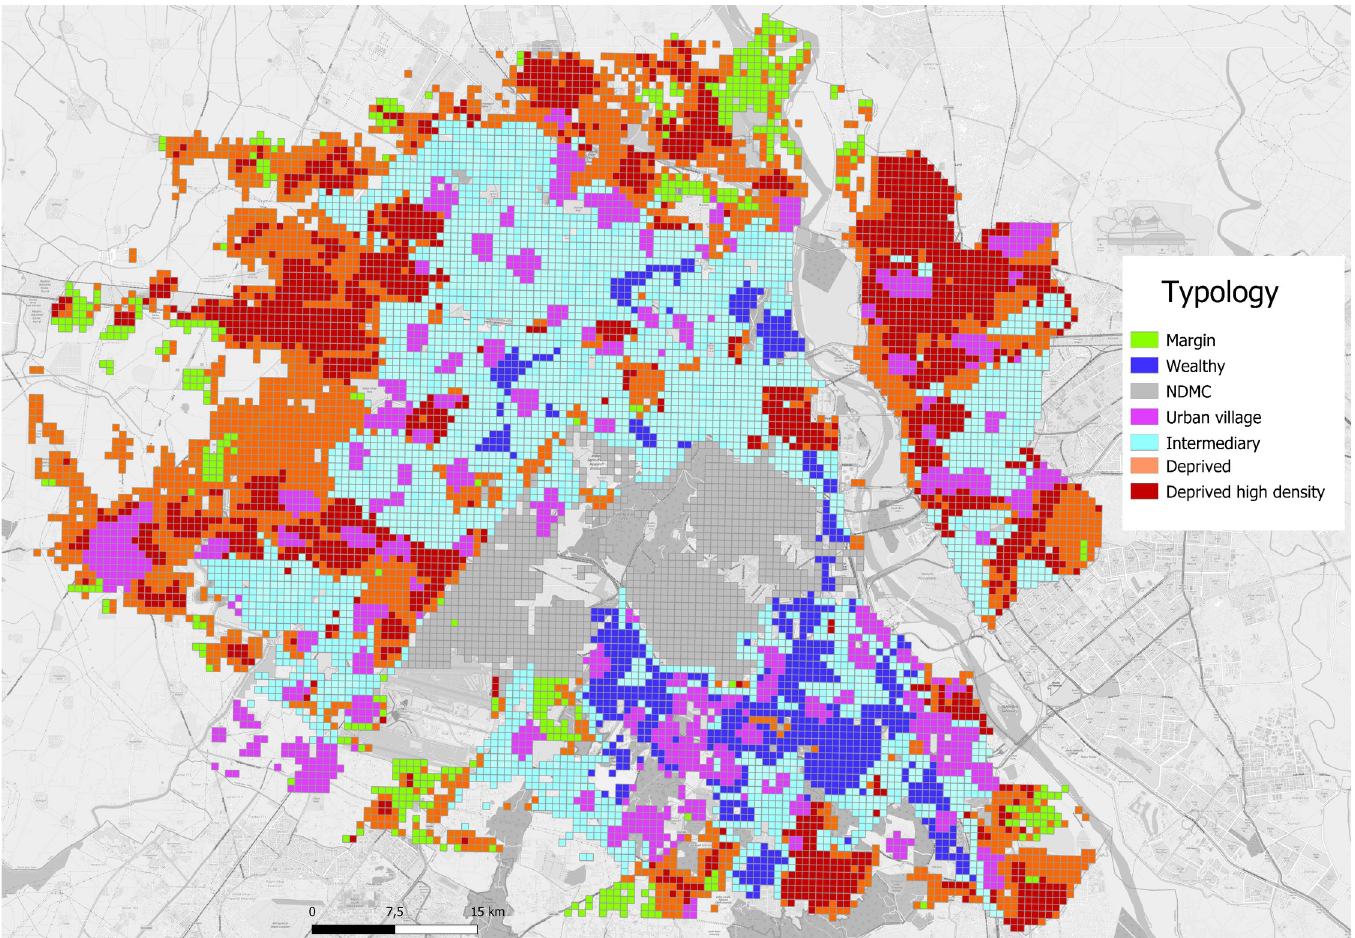
Fig 4. Socio-economic typology of colonies in Delhi (source Telle Olivier and OpenStreetMap). NDMC—New Delhi Municipal Corporation.